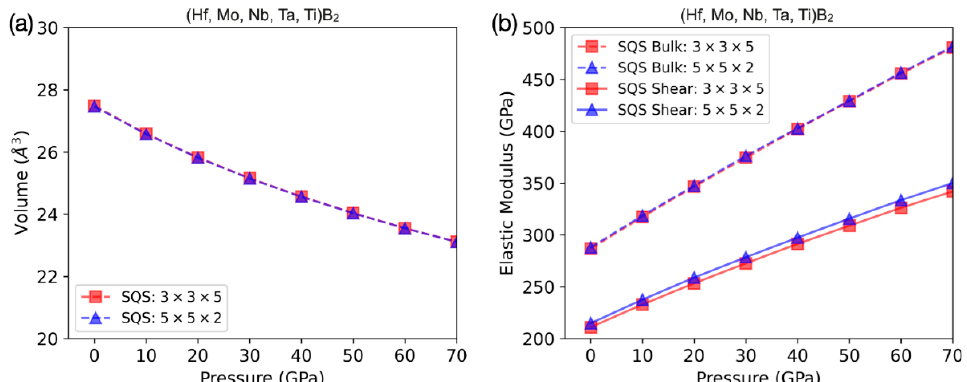
Figure 2. Volume and elastic moduli of different SQS structures computed for (Hf, Mo, Nb, Ta, Ti)B 2 . ( a ) The computed volumes of the 135-atom (red square) and 150-atom (blue triangle) SQS structures match well with each other. ( b ) The bulk and shear moduli computed by both SQS structures are also in very good agreement. The theoretical bulk and shear moduli at zero pressure from the 150-atom SQS structure are K 0 = 288 GPa and G 0 = 215 GPa, respectively.